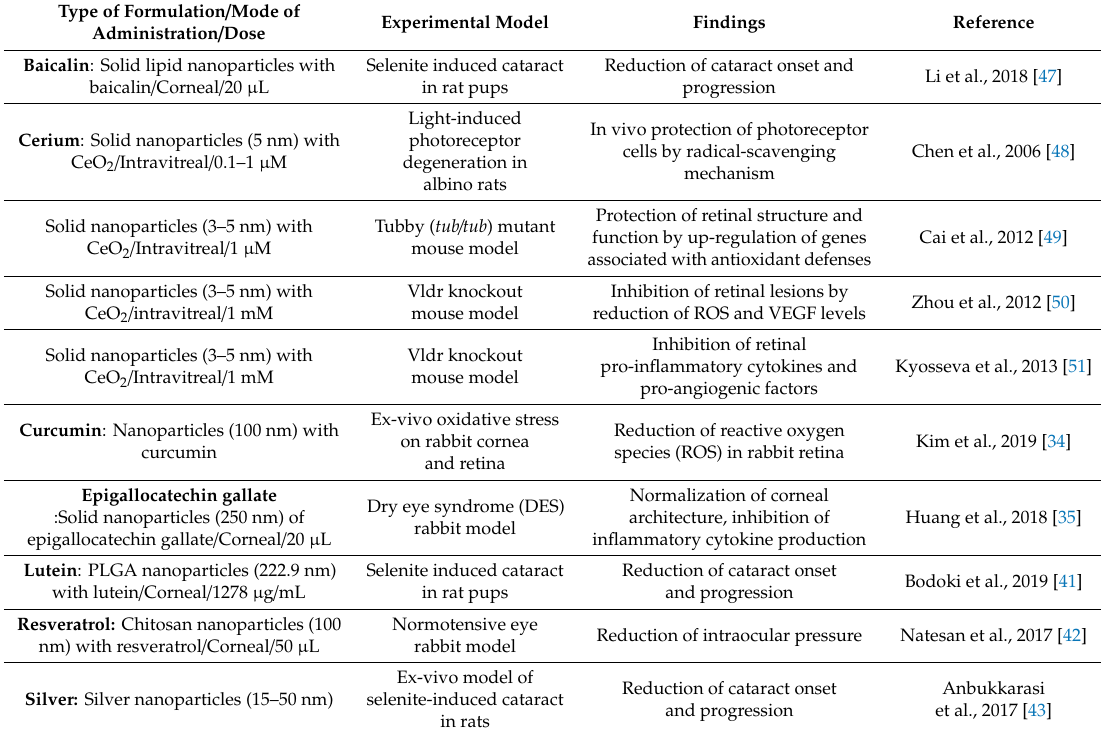
Table 2. In vivo and ex-vivo studies using ophthalmic nanosystems with antioxidants. Type of Formulation / Mode of Experimental Model Findings Administration / Dose